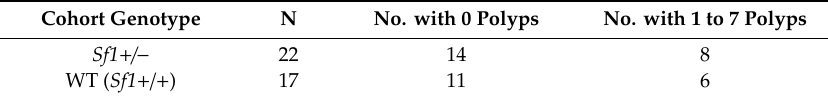
Figure 4. Polyps in WT and Sf1+/ − mice. ( a ) Comparison of polyp numbers in wild-type (WT) Sf1+/+ and Sf1+/ − genotypes; ( b ) Apc Min/+ and control ( Sf1+/+ and Sf1+/ − ) genotypes; and ( c ) Apc Min/+ ;Sf1+/ − and control genotypes. Quartile values are represented as described in the legend of Figure 2. Actual values are listed in Table 4. Table 3. Frequency distribution of polyps in Sf1 +/+ (WT) and Sf1 +/ − mice.